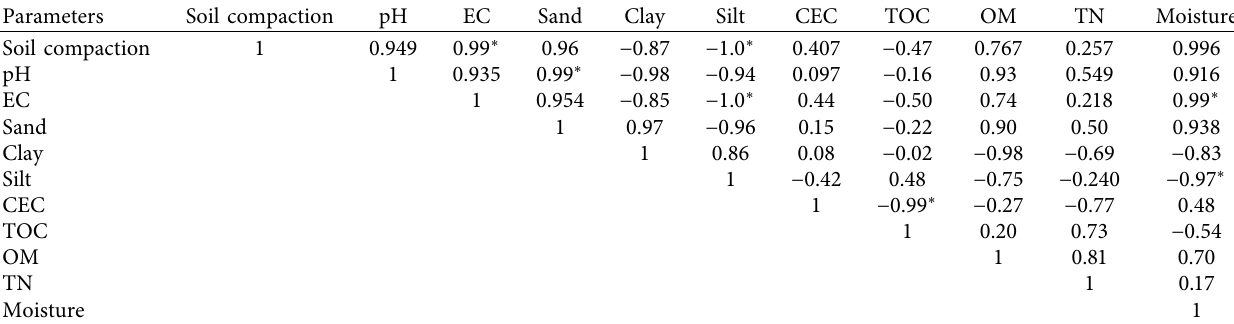
Table 2: The correlations between physiochemical parameters and soil